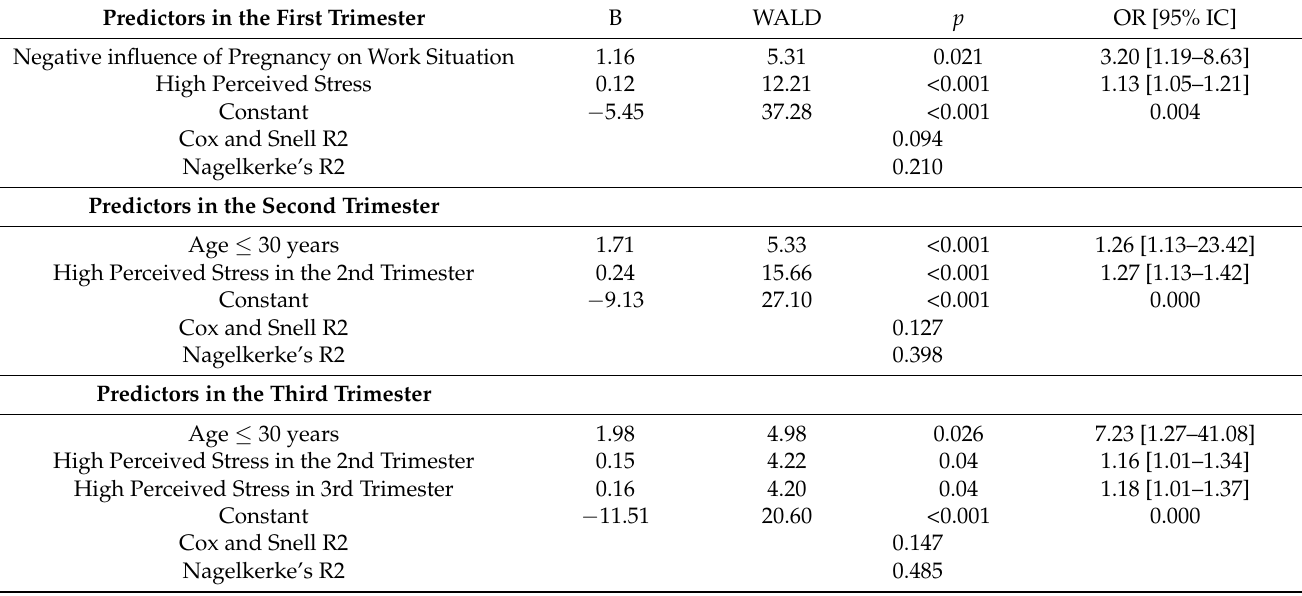
Table 5. Predictors of major depression in each